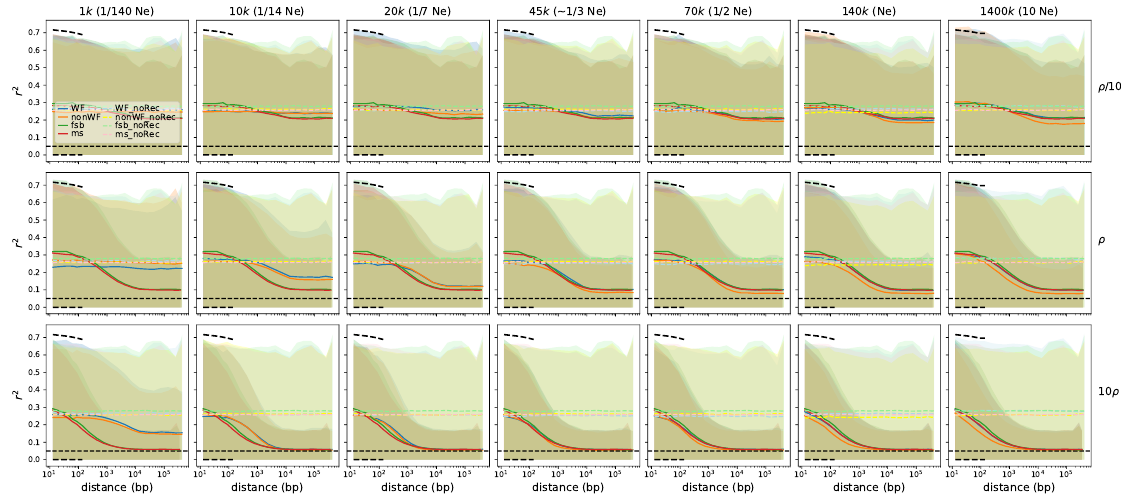
Figure S6 – Linkage disequilibrium for WF and nonWF simulations with various numbers of forward-simulated generations and recombination rates ( ρ ). Ne =140 000, λ = 12200 bp and RF=25. The horizontal dashed line is the expected r sampling 20 individuals (1/20). The shaded areas represent standard error of the mean; the standard deviation is 10 times larger (since we have 100 samples), as shown in figure S7 below.